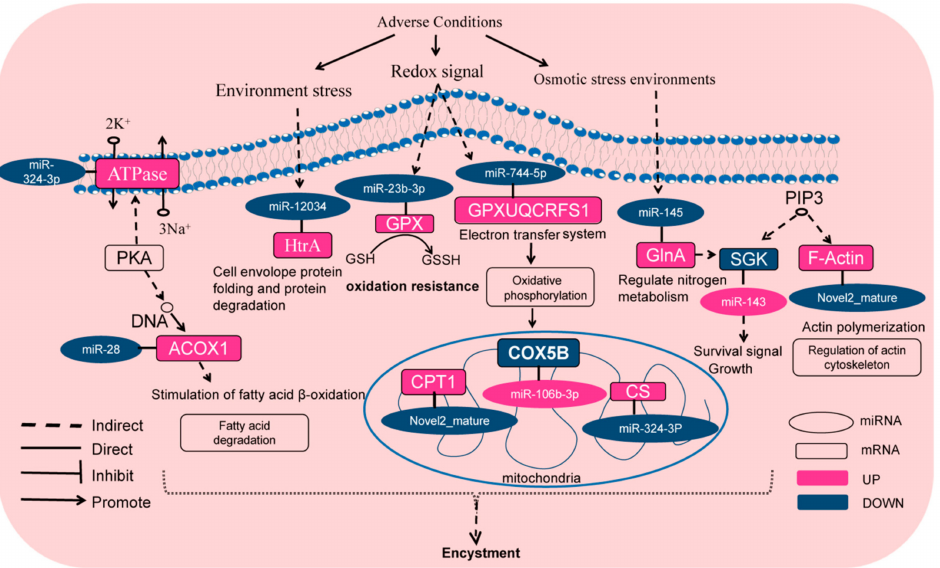
Figure 9. Schematic diagram of hypothetical signaling network of miRNAs regulating or promoting P. cristata encystment. Pink color indicates upregulation and blue color represent downregulation of gene expression during the encystment of P. cristata